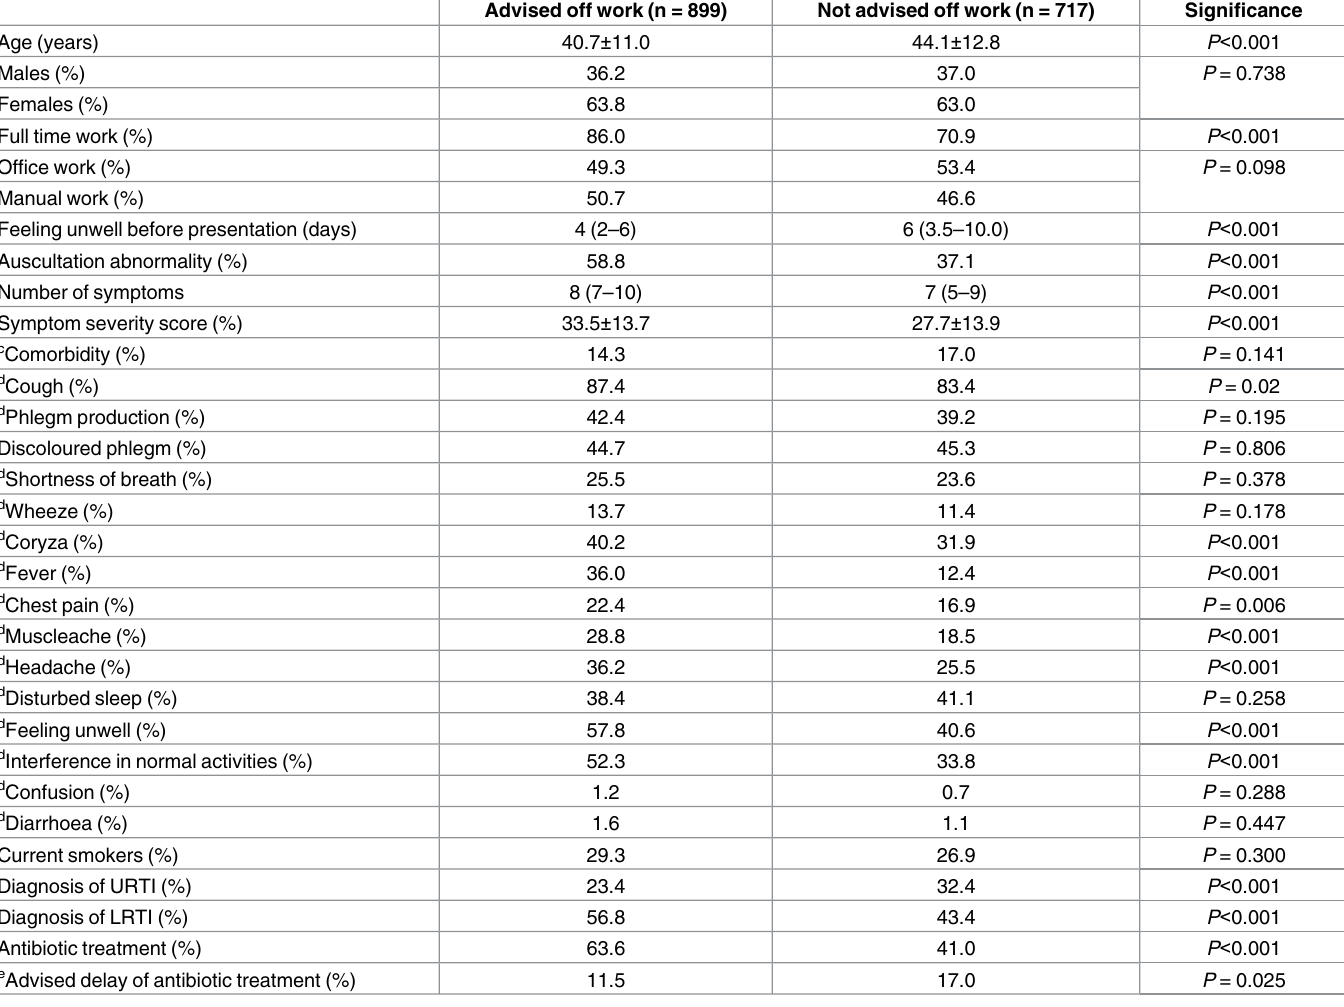
Table 3. Characteristic of employed patients related to advice to take time off work by family practitioners. Data presented as mean ± SDinflated for clusteringor median (25%-75%IQR) or percentagerelated to the total number of cases in particular subgroups